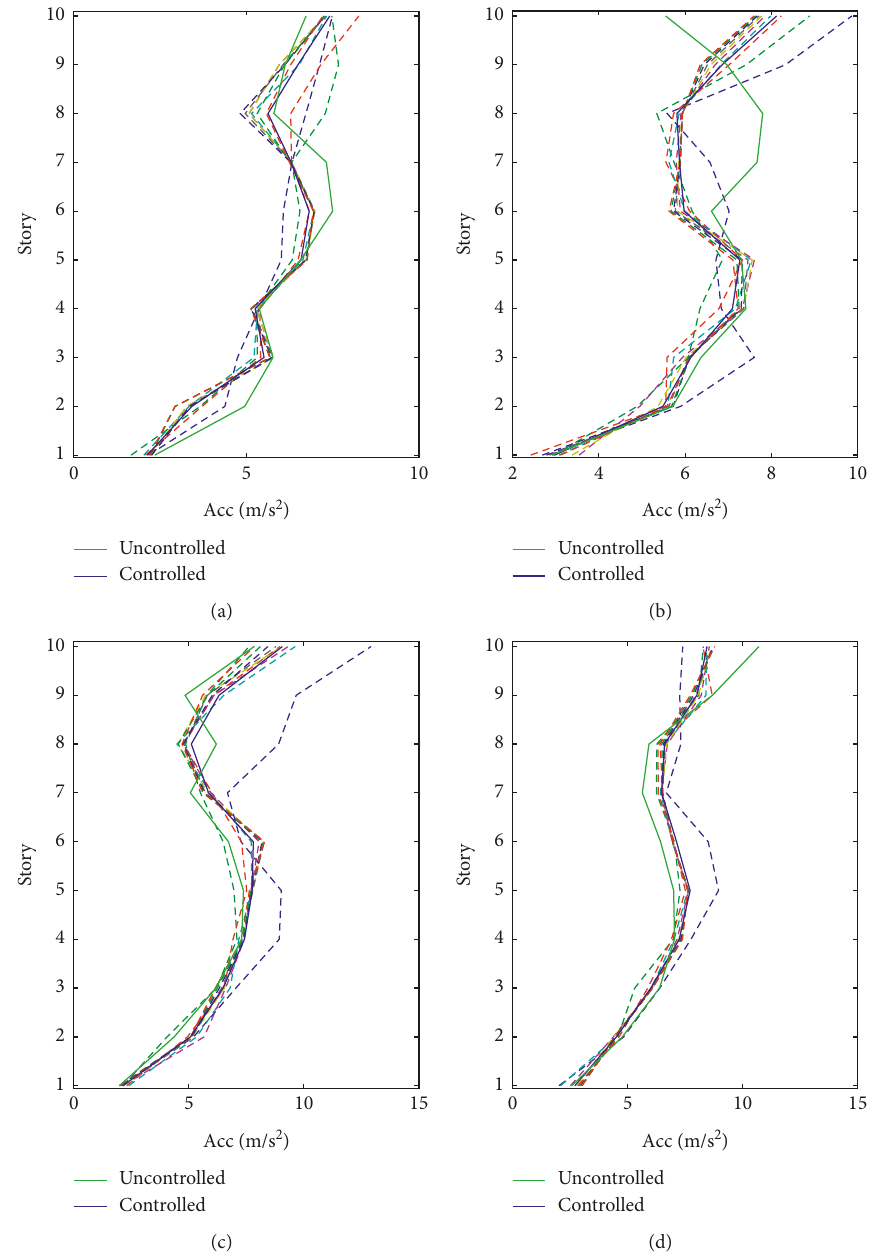
Figure 17: Control effect of structural maximum acceleration under 0.51g conditions (dashed lines indicate different schemes, blue solid lines indicate the mean value of different schemes, and green solid lines indicate uncontrolled structures): (a) El Centro; (b) Hachinohe; (c) Kobe; (d)